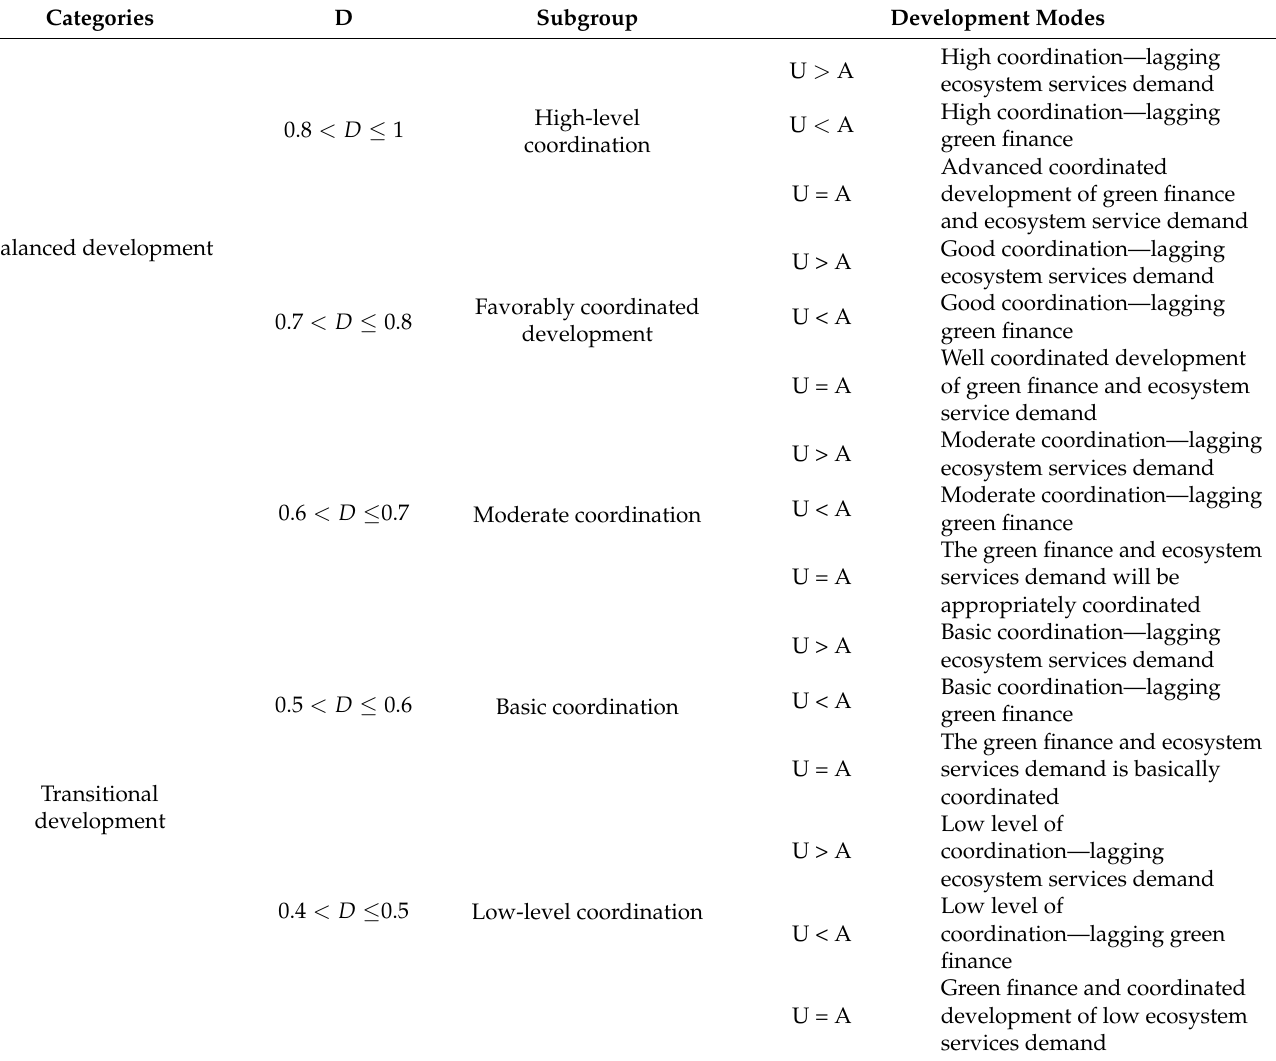
Table 3. Green finance and coupling coordination degree types of ecosystem service